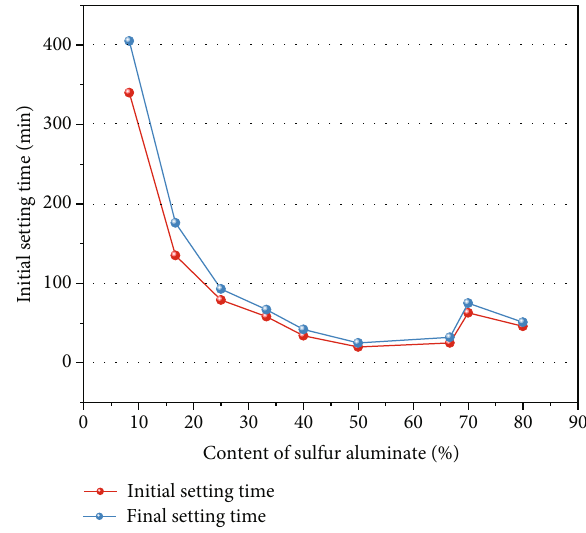
Figure 15: E ff ects of di ff erent dosages of sulfoaluminate cement on setting